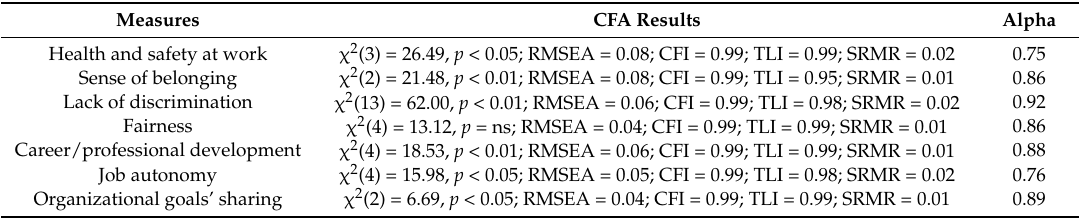
Table 1. Confirmatory factor analysis